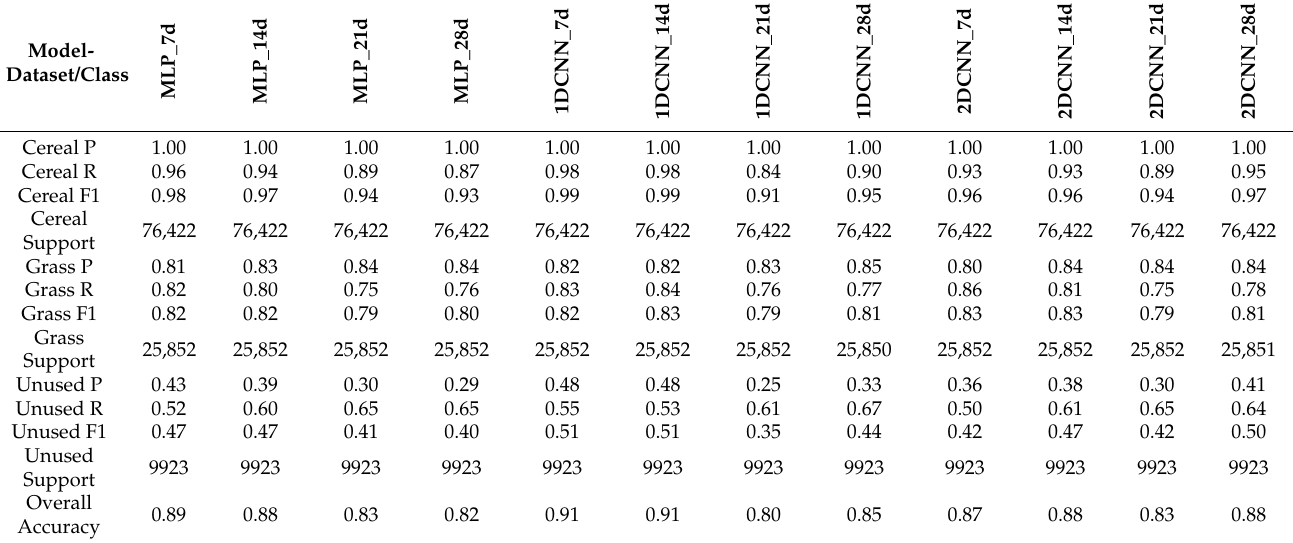
Table 4. Prediction accuracies of the twelve optimized model–dataset combinations as evaluated using the JOVA and PT